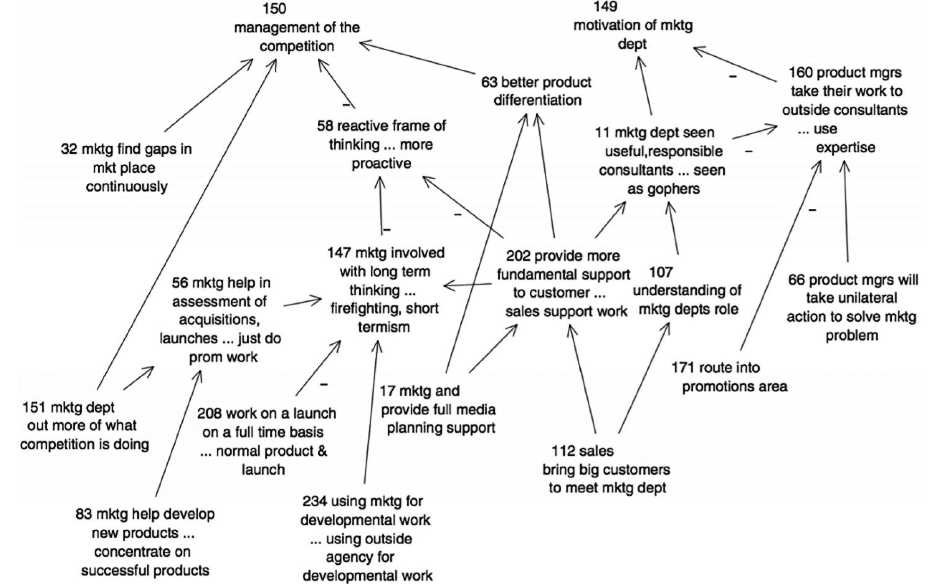
Figure 2. Partial example of a cognitive map (source: Eden, 2004, p.